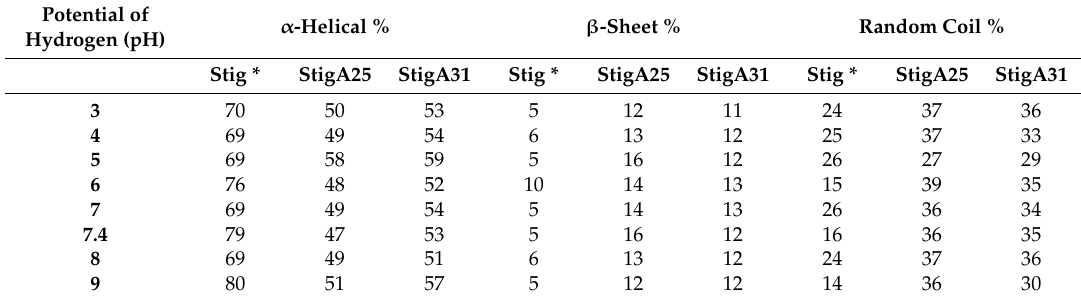
Table 3. Percentage of the secondary structure obtained by CD at different pH.